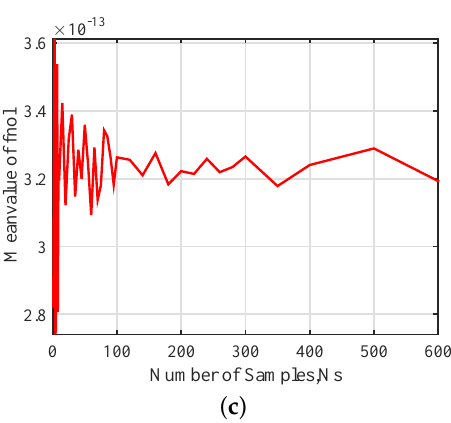
Figure 8. Stochastic convergence analysis of Mean value of output parameters: ( a ) f rn , ( b ) f of f and ( c ) f nol .